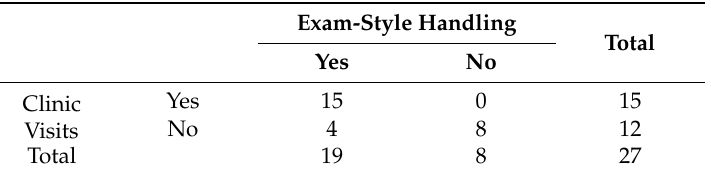
Table 5. Owner reported compliance with training protocols for all dog owners in the training treatment group (n = 27) displaying the number of owners who performed exam-style handling on their dog and brought their dog to the clinic for the required minimum number of sessions over the course of the study. Compliant owners (n = 15) completed three or four weeks of training, and non-compliant owners (n = 12) conducted training for zero, one, or two weeks.